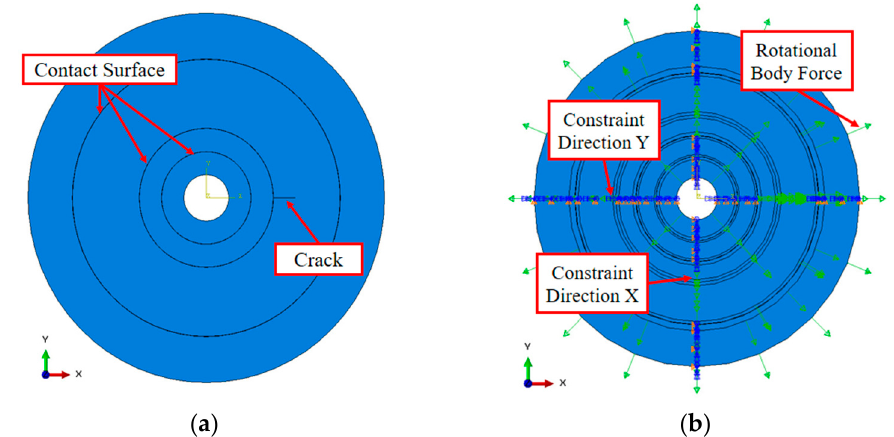
Figure 9. 2D finite element model. ( a ) The 2D plane model consists of thick-walled cylinders with four-layers under interference fit. ( b ) The model applies the boundary conditions. Table 3. Thick-walled cylinder